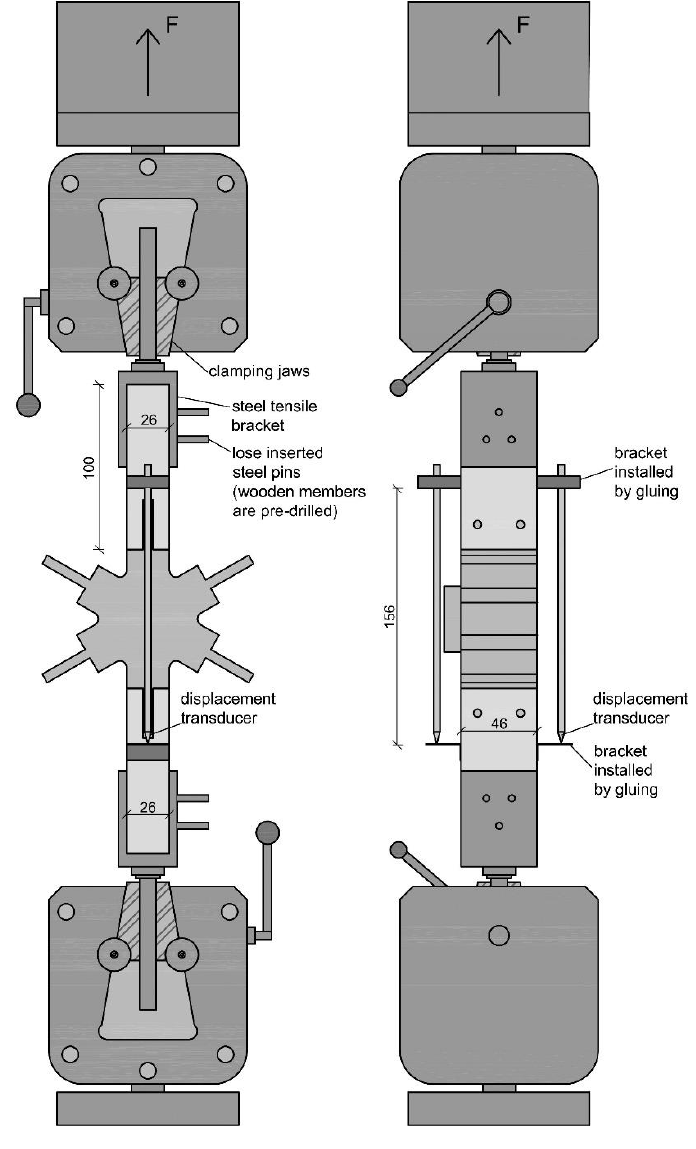
Figure 6. Test setup of the tension tests.